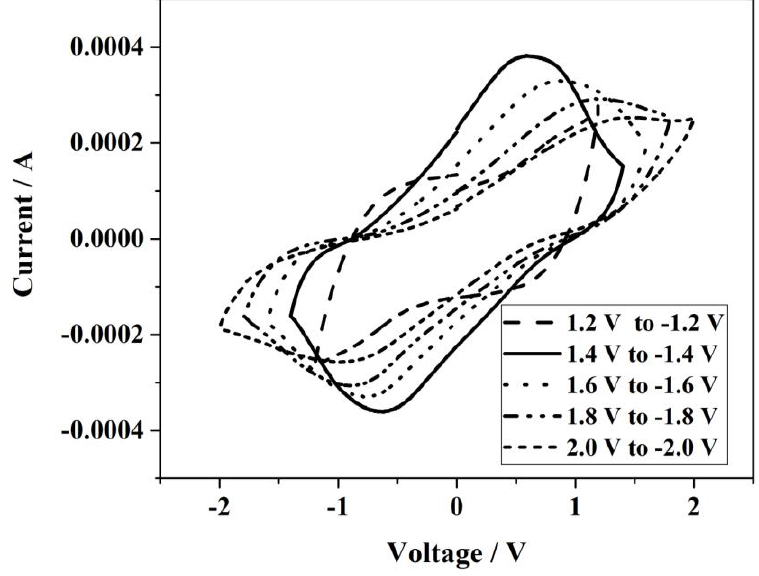
Figure 5: Cyclic Voltammograms obtained by varying the potential window of cycling of the redox capacitor (scan rate : 10